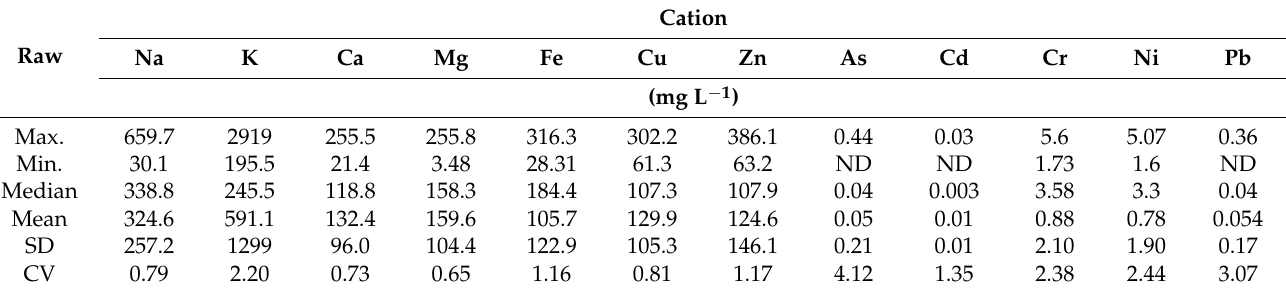
Table 3. Content of various cations and heavy metal in fresh swine